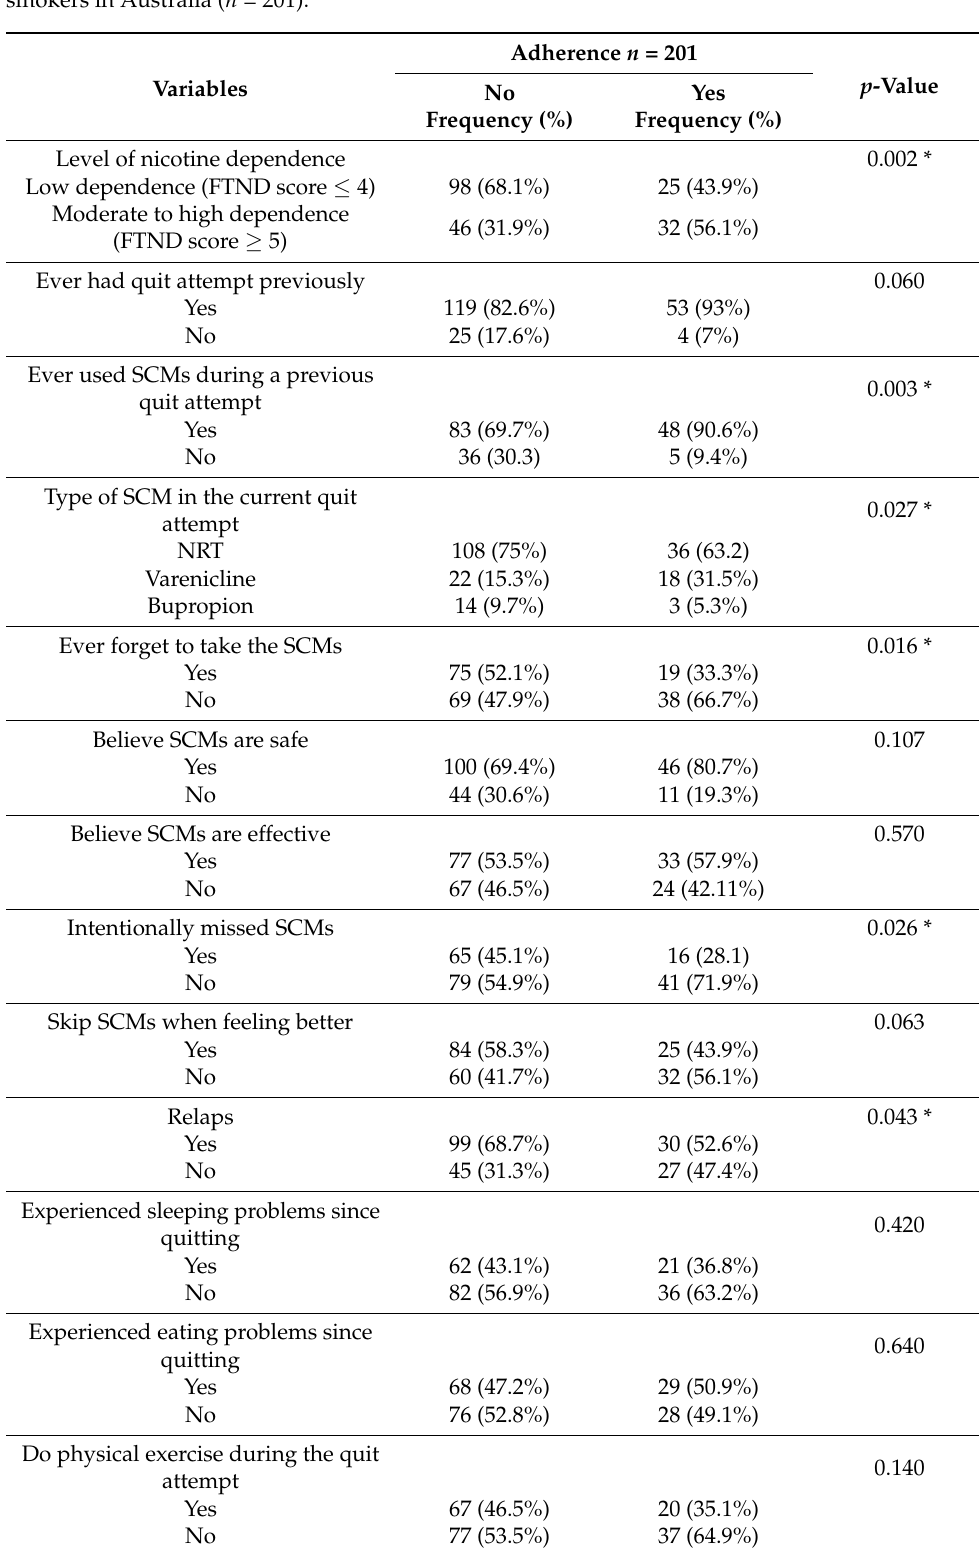
Table 2. Smoking characteristics, quit attempts, and beliefs about SCMs among smokers and ex- smokers in Australia ( n =